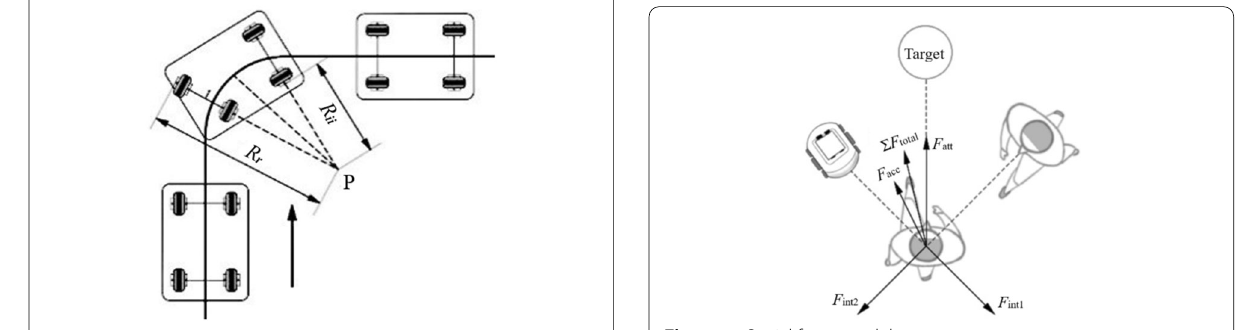
Figure 3 Schematic of robot turning motion Figure 4 Social force